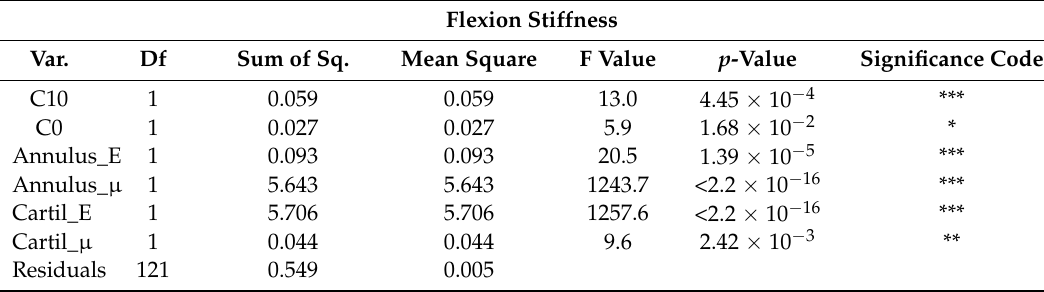
Table 24. ANOVA table for a flexion stiffness linear model.